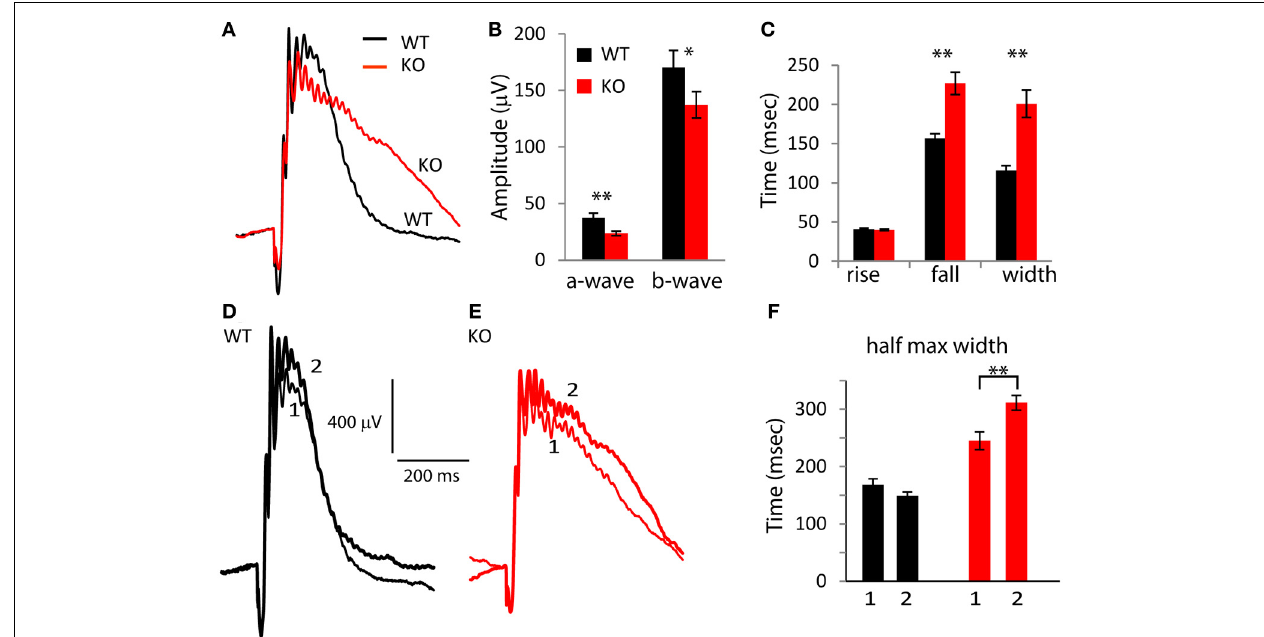
FIGURE 3 | Absence of PDE9A slows the falling phase of the b-wave of a saturating flash under photopic conditions. (A) Average responses of WT and KO retinas to a saturating flash (1000scot cd s m − 2 ) after 2s light adaptation. The responses to both the first and second saturating flashes (presented before and after stimulation with UV and green light, respectively) in each retina were averaged. (B) Response amplitudes of the a- and b-waves